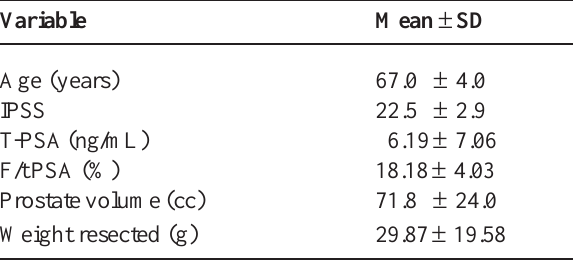
Table 1 – Baseline values (n = 30